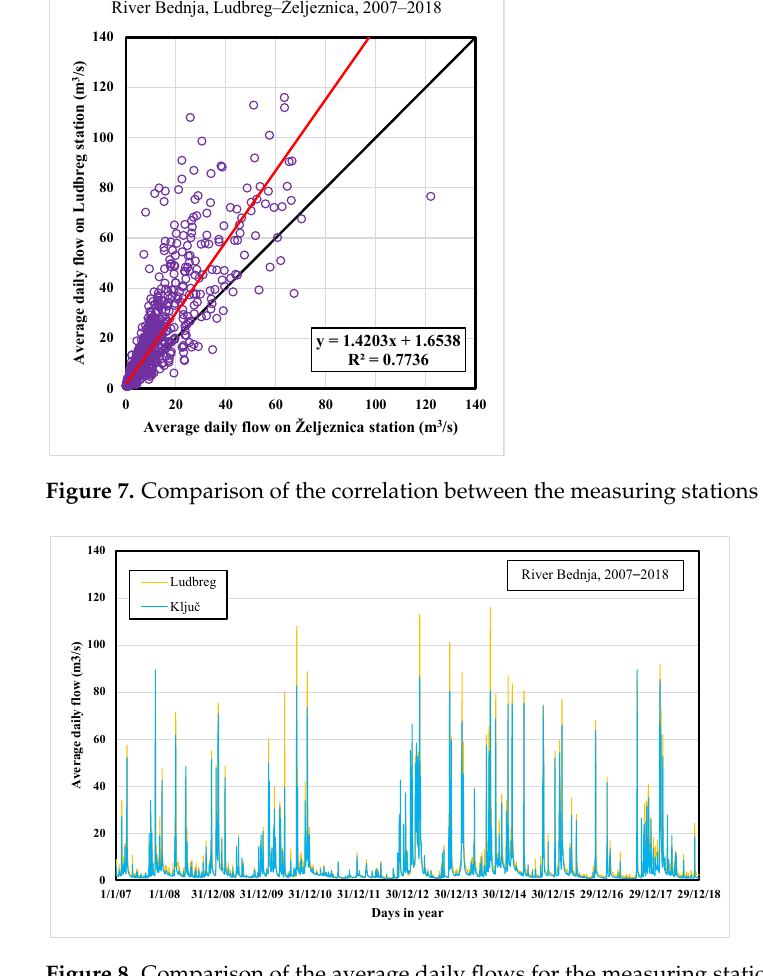
Figure 9. Comparison of the correlation between the measuring stations Ludbreg and Klju č .